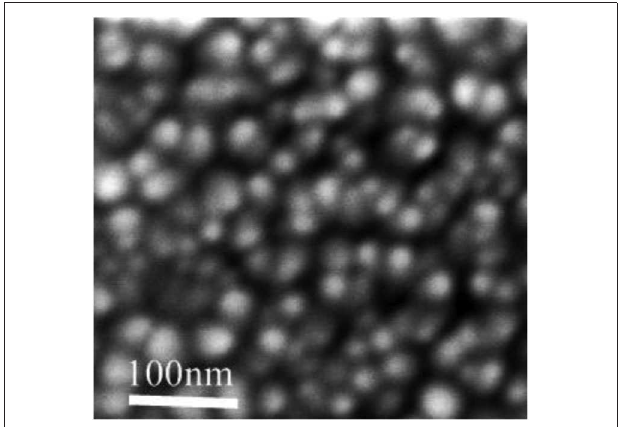
FIGURE 4 | The SEM patterns of InN films at N 2 flux with 80 sccm.